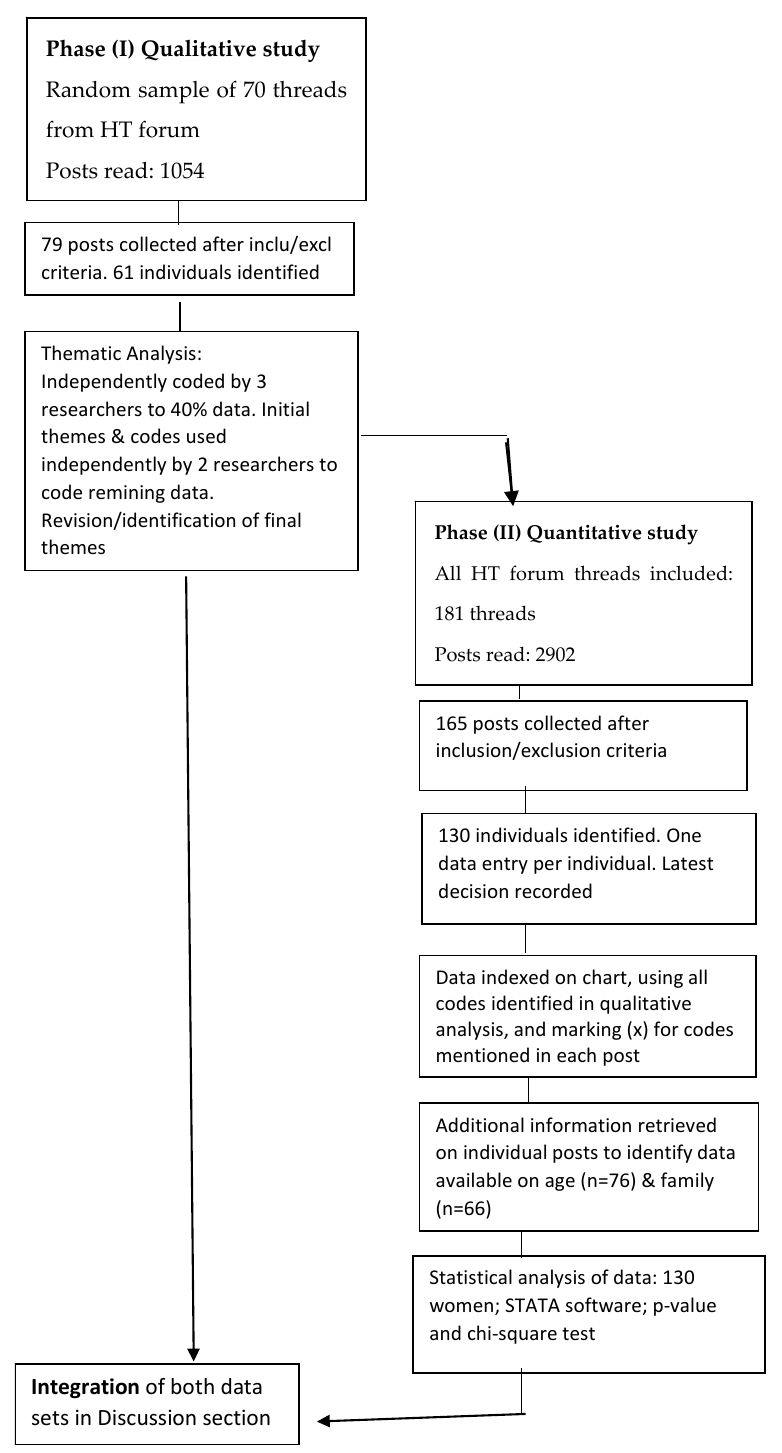
Figure 1. Flowchart of the mixed-methods